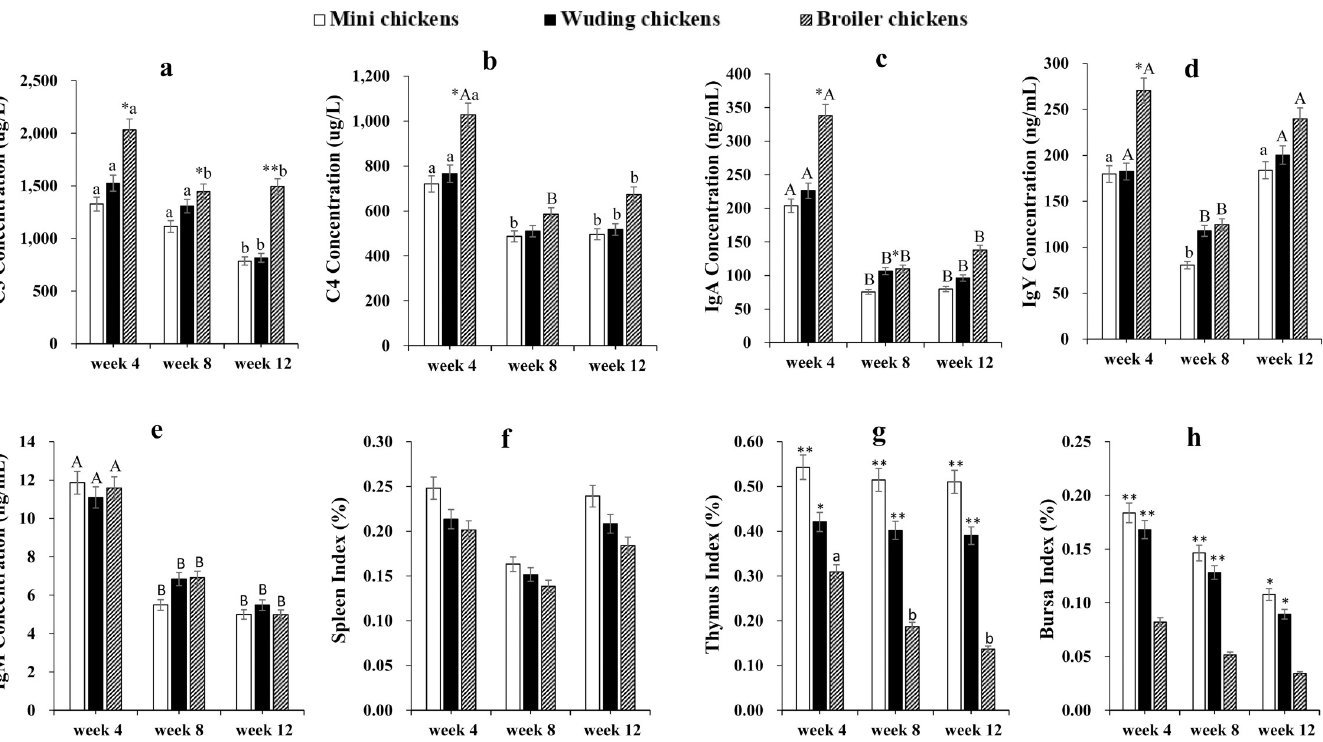
Fig 1. Blood complements, Igs, and indexes of immune organs. Comparative analysis of blood complements C3 (a), C4 (b), IgA (c), IgY (d), IgM (e) and indexes of spleen (f), thymus (g), and bursa of Fabricius (h) of three chicken types at weeks 4, 8, 12. Twenty Chickens from each chicken type at three time points were measured. Measurements were done in duplicate. Spleen (f), thymus (g), and bursa of Fabricius (h) were weighed to calculate the average index of immune organs at each time point. Statistical significance of difference between chickens is labeled by � for p < 0.05, and �� for p < 0.01. Statistical significance of difference between different ages within a chicken is labeled by lower-case letters for p < 0.05, and super-case letters for p < 0.01.